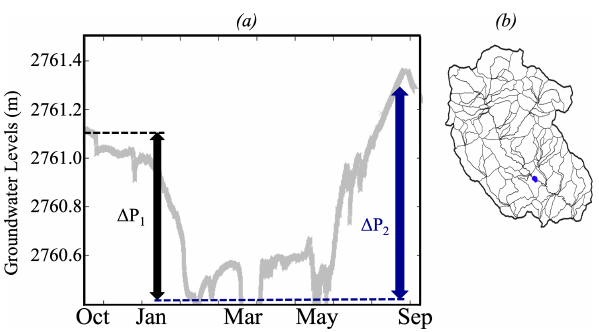
Figure A1. (a) Measured groundwater levels in WY2016 at a sta- tion located in blue in (b)